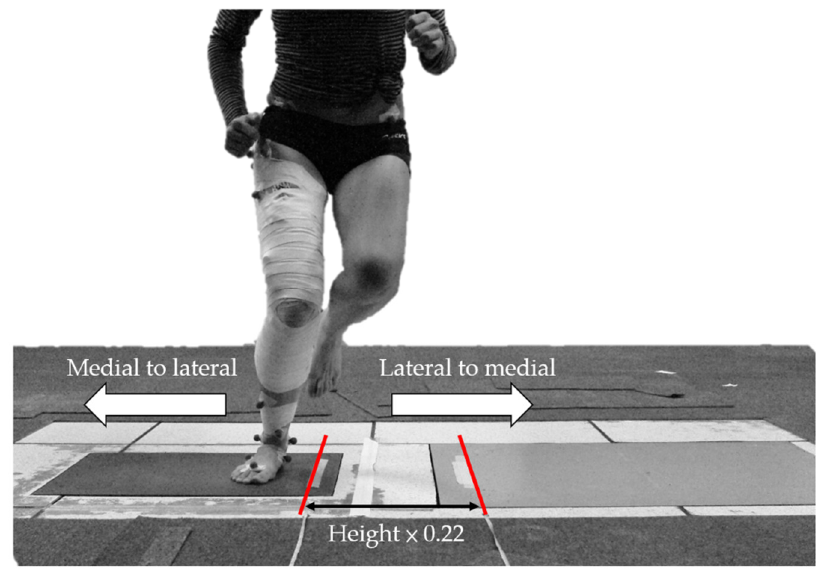
Figure 3. The participants were asked to preform single-leg hops side to side between two parallel lines. The distance between the two parallel lines was the product of participant’s height and 0.22.